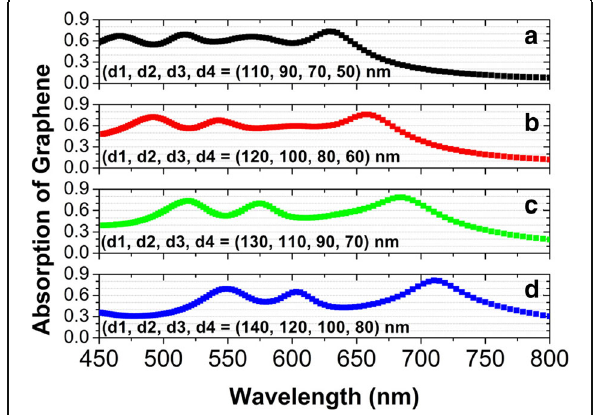
Fig. 5 ( a )-( d ) Corresponding normal-incidence absorption spectra of monolayer graphene in the wavelength range from 450 to 800 nm with the diameters of four Ag nanodisks are varied, but the other parameters are the same as those in Fig.